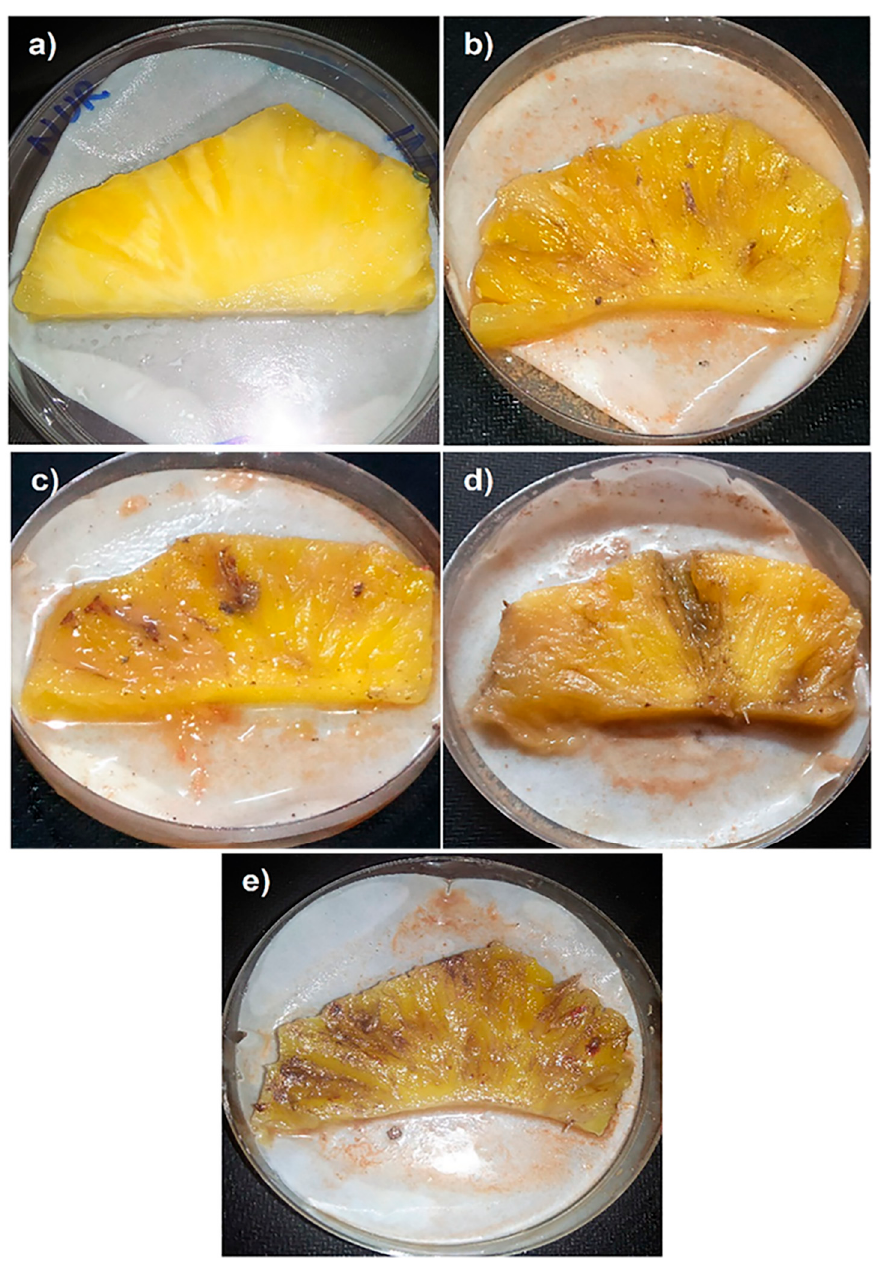
Figure 5. The disease rating of localized lesions of pineapple fruitlets (rating 0–4). ( a ) Disease rating 0; ( b ) disease rating 1; ( c ) disease rating 2; ( d ) disease rating 3; ( e ) disease rating 4.